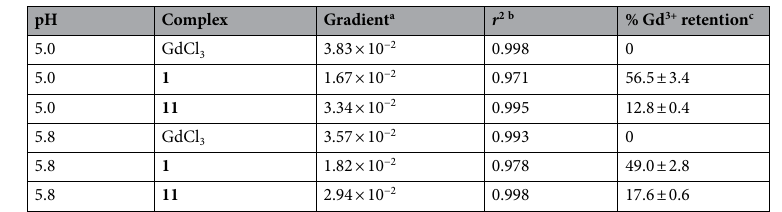
Table 1. Competitive stability of complexes 1 and 11 . a Slope of the line of best fit resulting from a plot of the average data using 10 different concentrations (2.0–250 μM). b Regression analysis of the line of best fit. c Percentage of Gd 3+ retained by the phosphonium complex over a period of 24 h, as determined by the shift in absorbance from 433 to 573 nm, averaged across all data